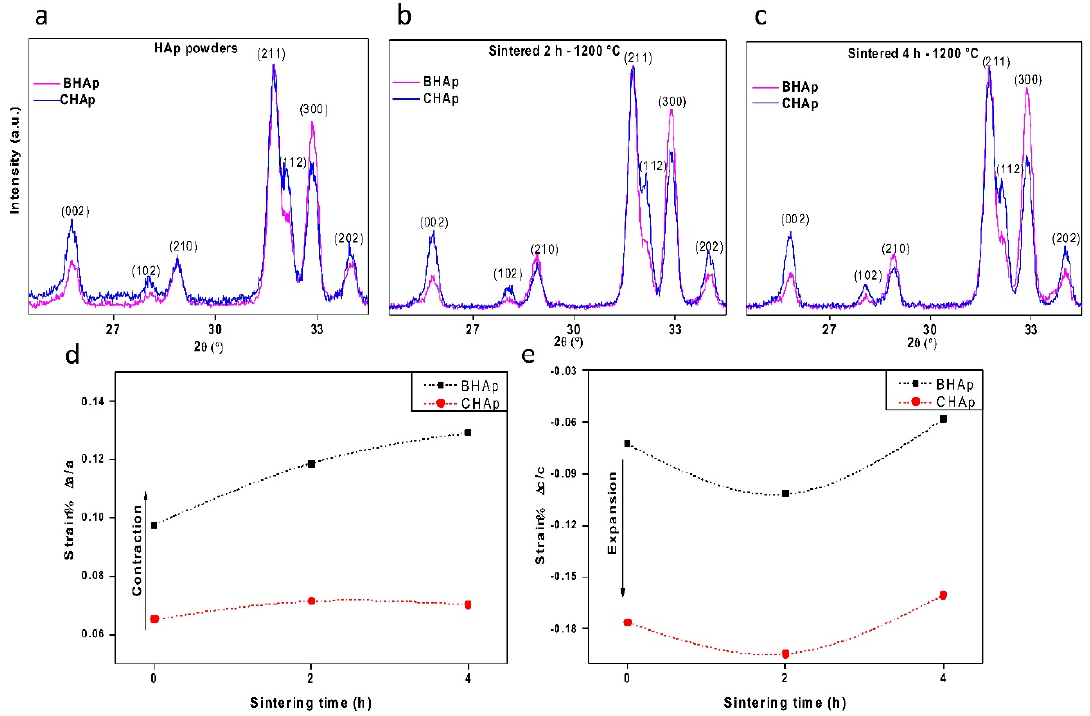
Figure 4. Variations in the XRD peaks intensities in (0 0 2), (2 1 1), (3 0 0) for the bovine-derived HAp and the synthetic Hap: ( a ) powders; and ( b ) 2 h and ( c ) 4 h sintered ceramics. ( d , e ) Deformation of lattice parameters in ( a , c ).